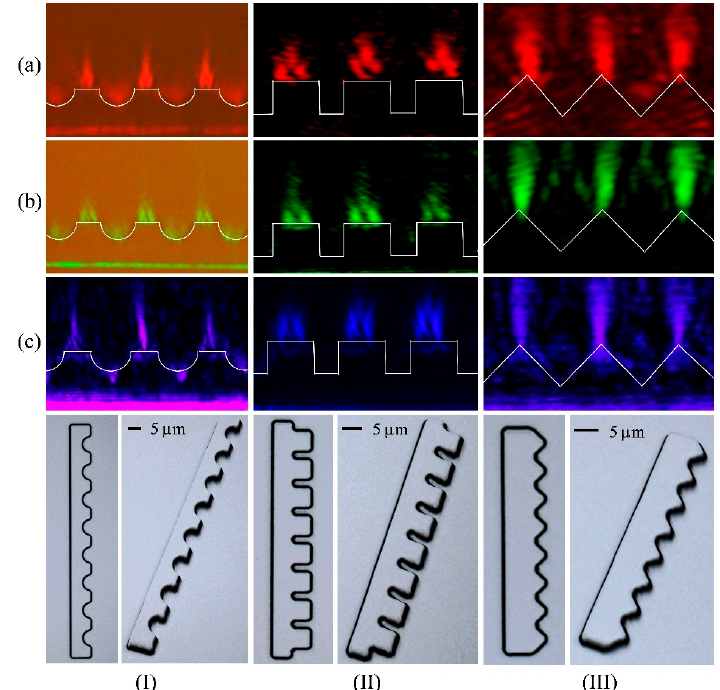
Figure 8. The raw experimental images of power flow distributions for the three types of phase di ff raction gratings having grooves with hemispherical ( I ), rectangular ( II ) and saw-tooth ( III ) profiles, at incident wavelengths ( a ) 405 nm, ( b ) 532 nm and ( c ) 671 nm. In the bottom, LSDM images of ( I ) hemispherical, ( II ) rectangular and ( III ) saw-tooth phase diffraction gratings; top view (left side) and perspective view (right side) are shown.